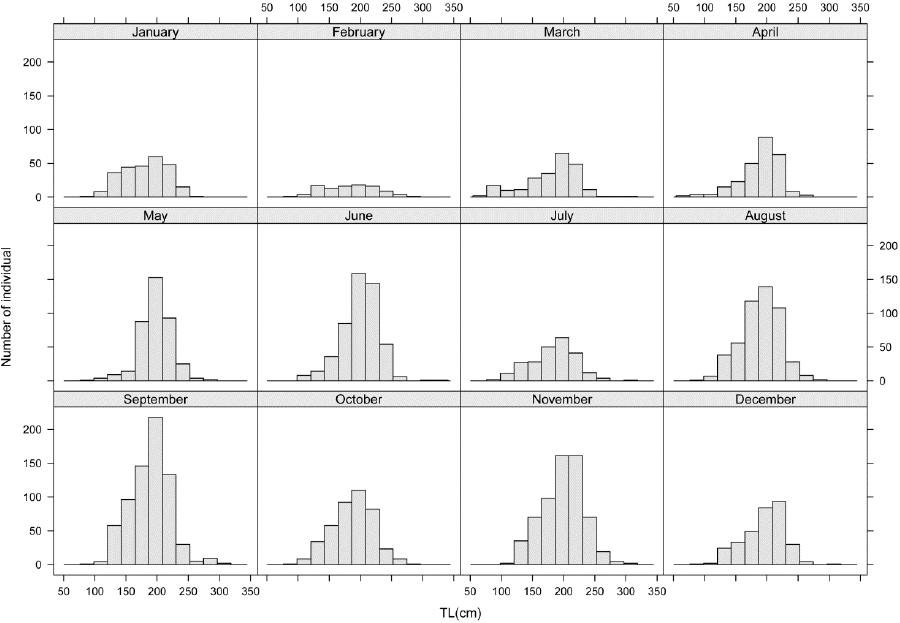
Figure 2. Histograms of landed silky shark total length (TL) (cm) pooled by month for 2015 and 2016.